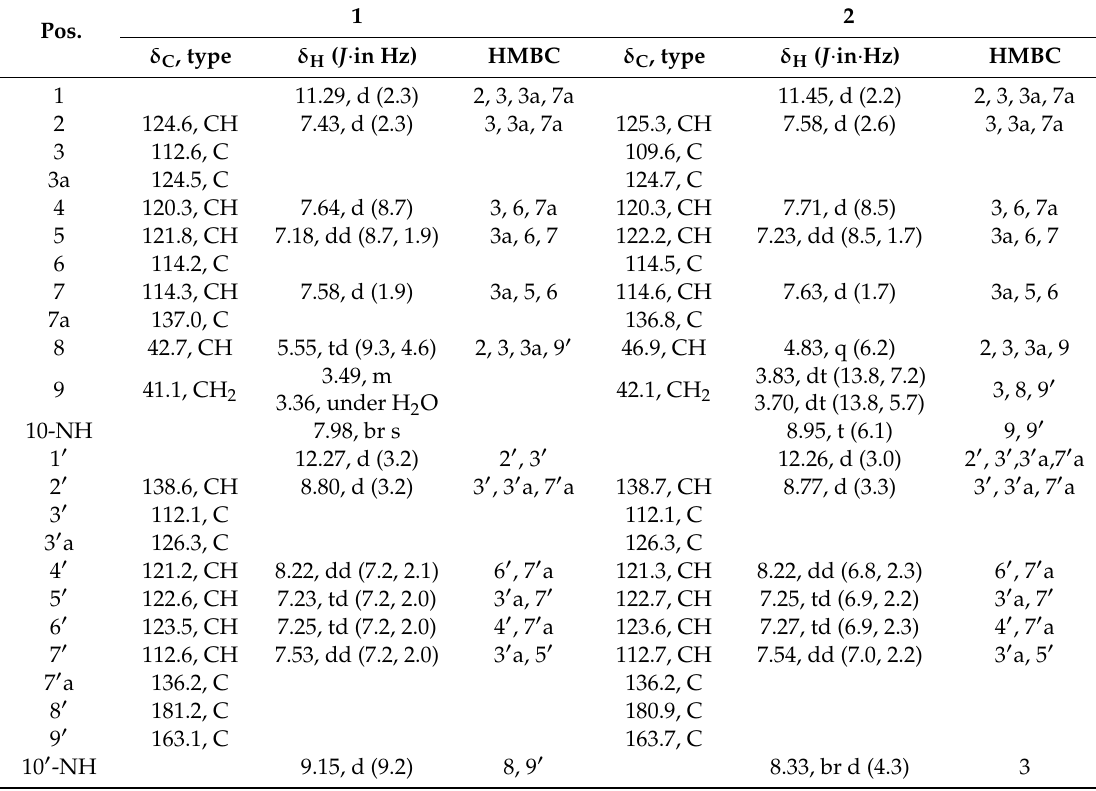
Table 1. NMR data for 1 and 2 in DMSO- d 6 ( 1 H-NMR at 500 MHz and 13 C-NMR at 125 MHz).